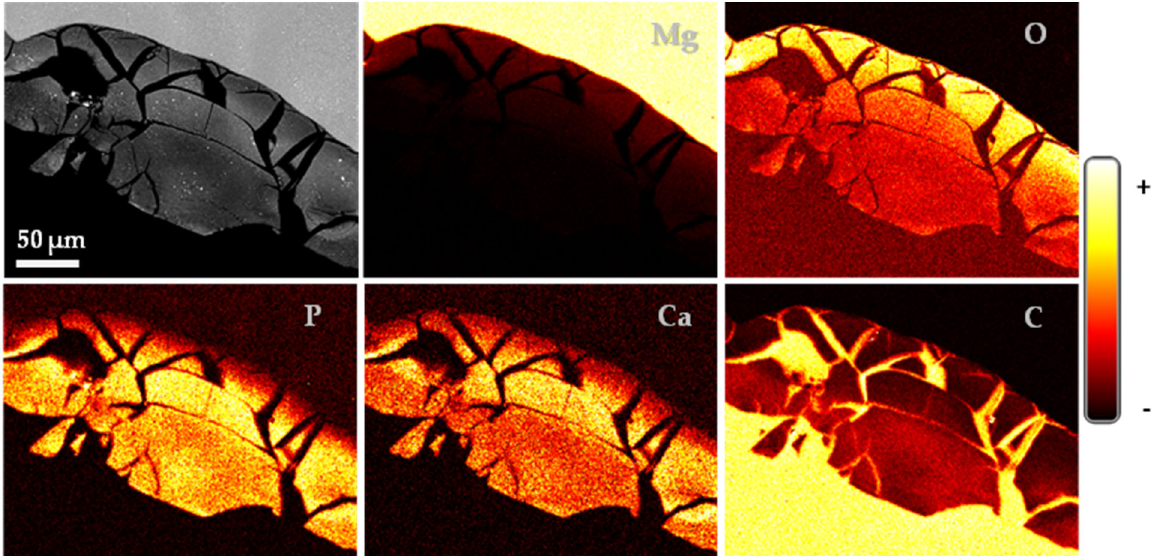
Figure 5. SEM EDS elemental mapping of cross sections of a 7 ‐ day corroded sample analysing the presence of Mg (top centre), O (top right), P (bottom left), Ca (bottom centre), and C (bottom right). High concentration levels are shown in yellow and low concentration levels in red.